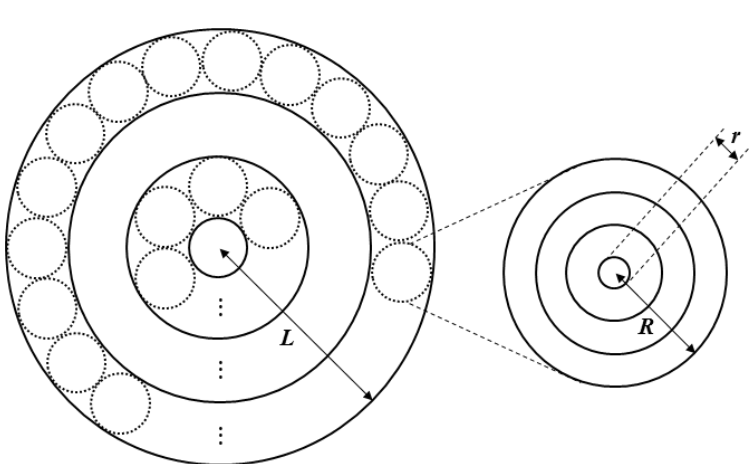
Figure 2. Network approximation model.